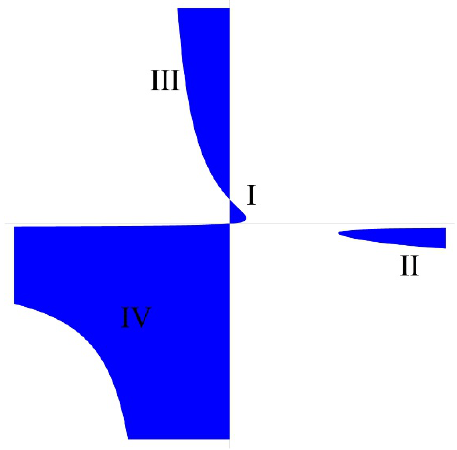
Figure 9 . Subregions for the integration of the double box diagram with two adjacent external massive leg on the maximal cut. The parameters for this plot are set as s = 1, (cid:31) = 1 = 3, (cid:20) 1 = 1 = 5 and (cid:20) 2 = 1 = 7. On the horizontal and vertical axis we have x and y ,